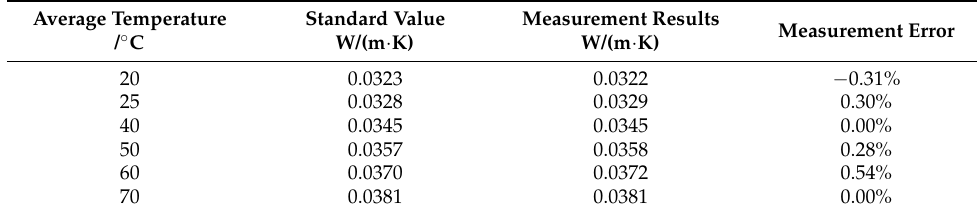
Table 1. Comparison of the measurement results of national standard sample reference plates.